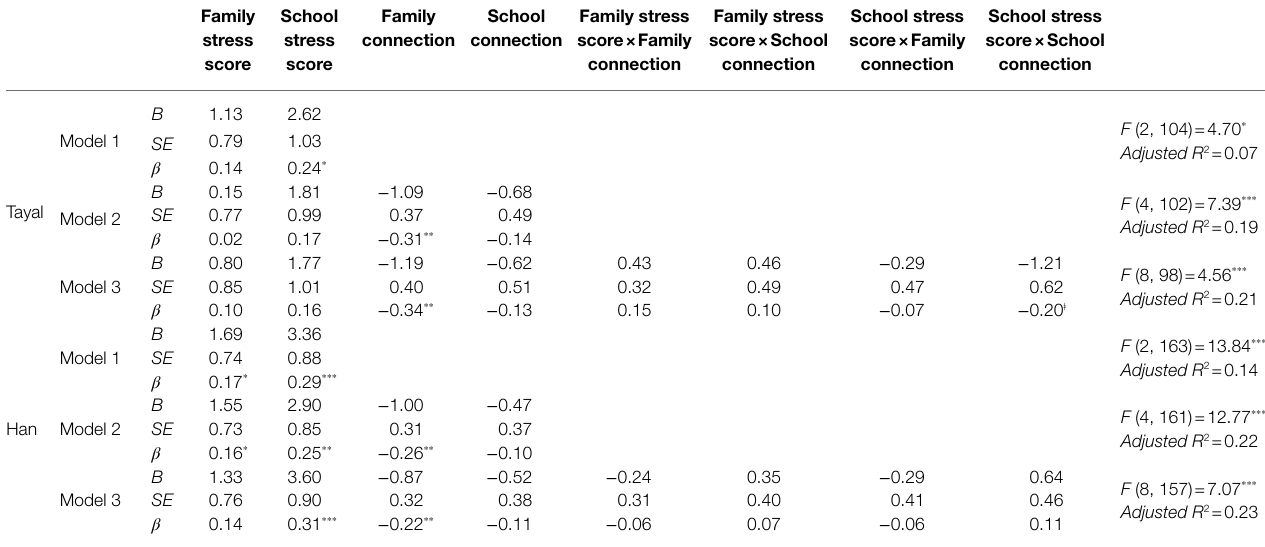
TABLE 7 | Hierarchical regression results on Tayal’s and Han’s depression using cumulative family and school stress scores.